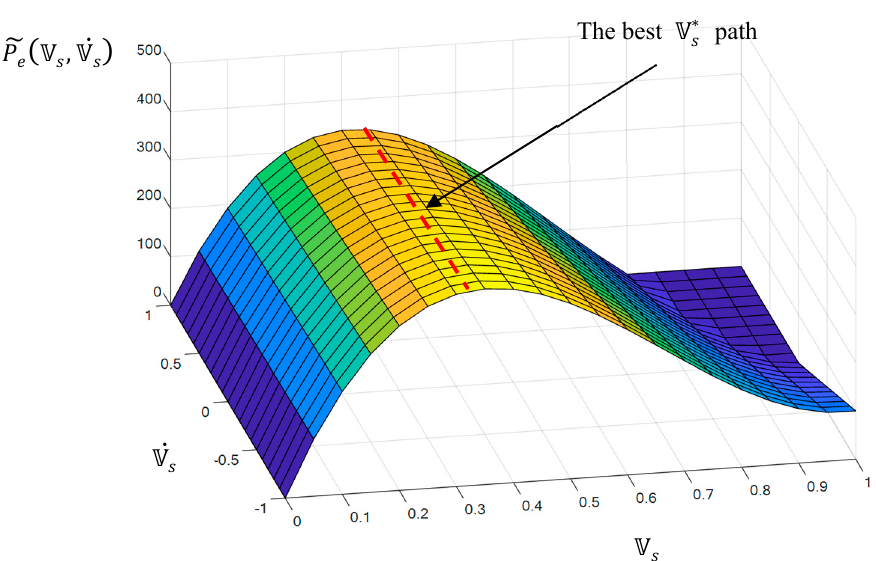
Figure 3. Power (cid:101) P e function of the dimensionless rotor dynamics at fixed wind Figure 3. Power 𝑃 (cid:3032) (cid:3561) function of the dimensionless rotor dynamics at fixed wind speed.